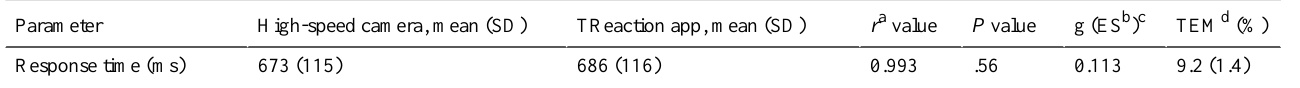
Table 1. Mean and standard deviation for the response time obtained using the high-speed camera and TReaction app (n=59).